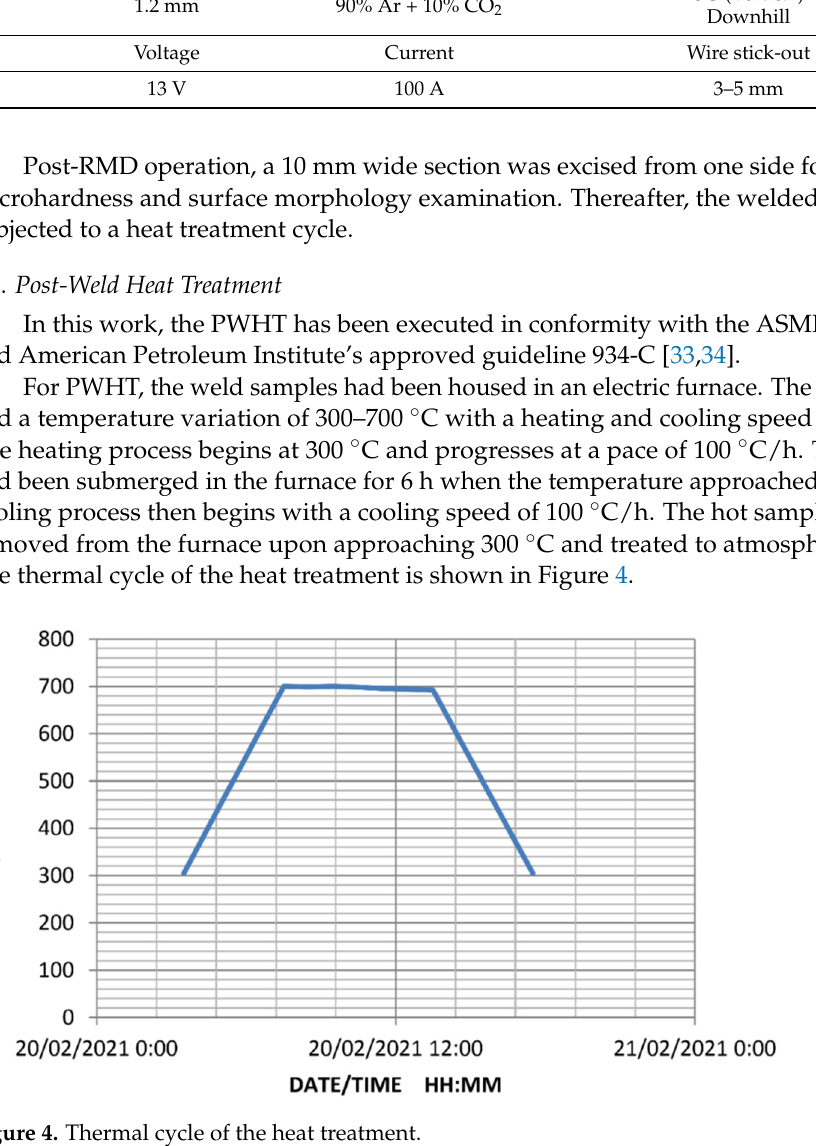
Figure 4. Thermal cycle of the heat treatment.